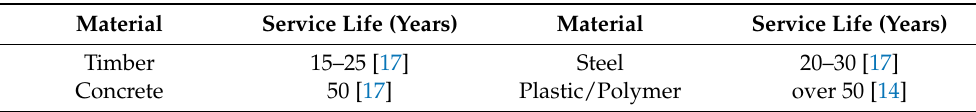
Table 5. Expected Life Cycle of Different Types of